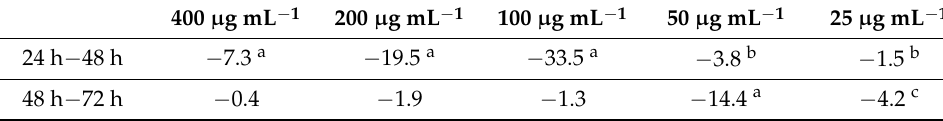
Table 3. Variation in Percentage Mortality of M. incognita at each Concentration.